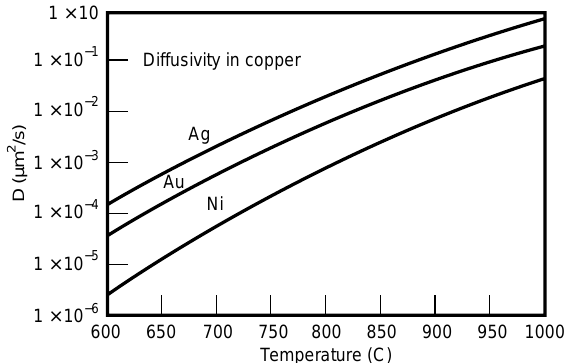
FIG. 7. Comparison of the diffusivity of Ag, Au, and Ni in copper as a function of temperature.